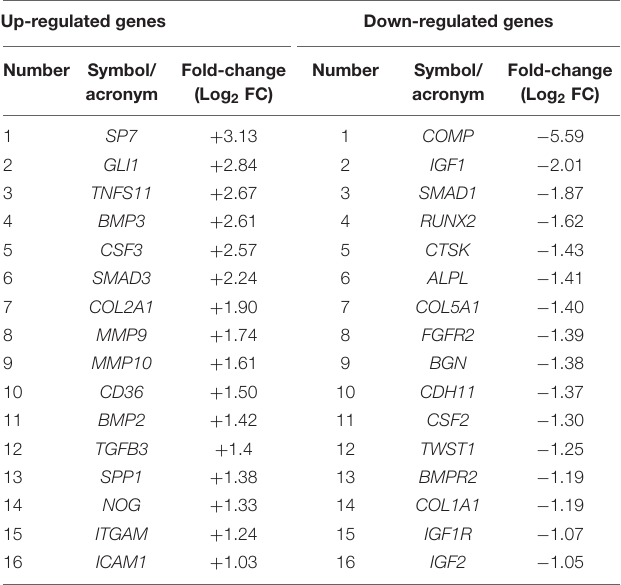
TABLE 1 | Genes found to be up- or down-regulated in human bone marrow-derived mesenchymal stem cells (hBMSCs) grown on the scaffold at day